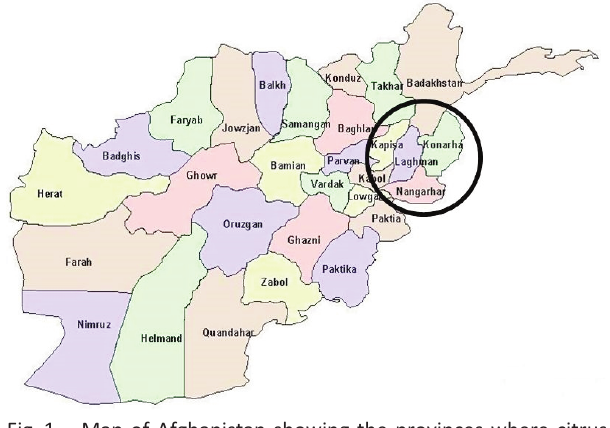
Fig. 1 - Map of Afghanistan showing the provinces where citrus production is located and where the survey was carried